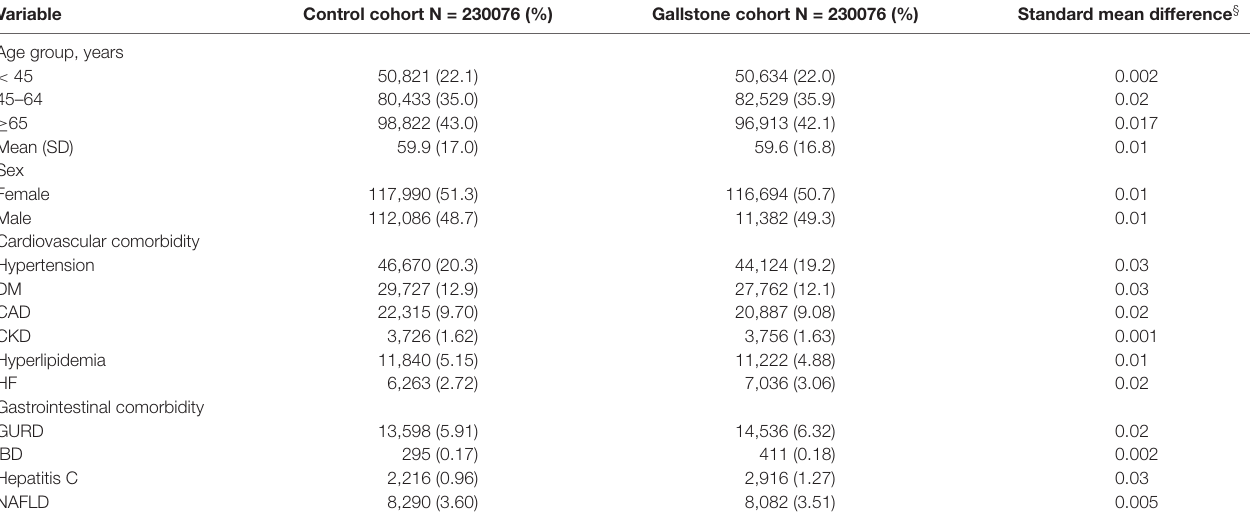
TABLE 1 | Demographic characteristics and comorbidities in GD and control